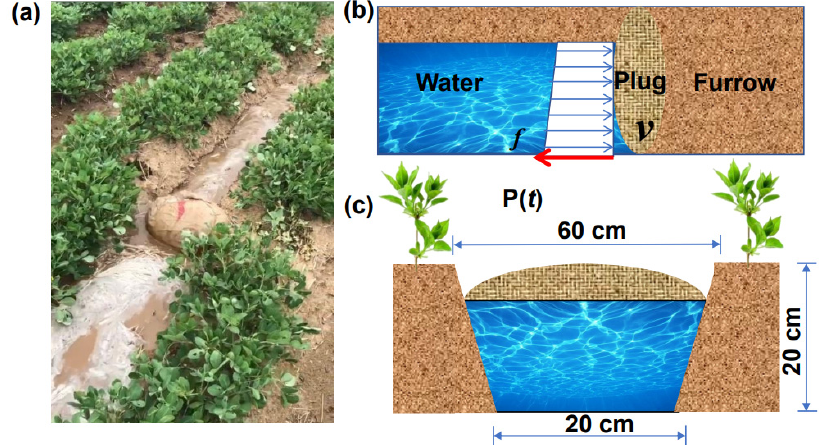
Figure 1. Overview of the furrow and plug. ( a ) Photo from the field. ( b ) Longitudinal section of the furrow. ( c ) Cross section of the furrow.